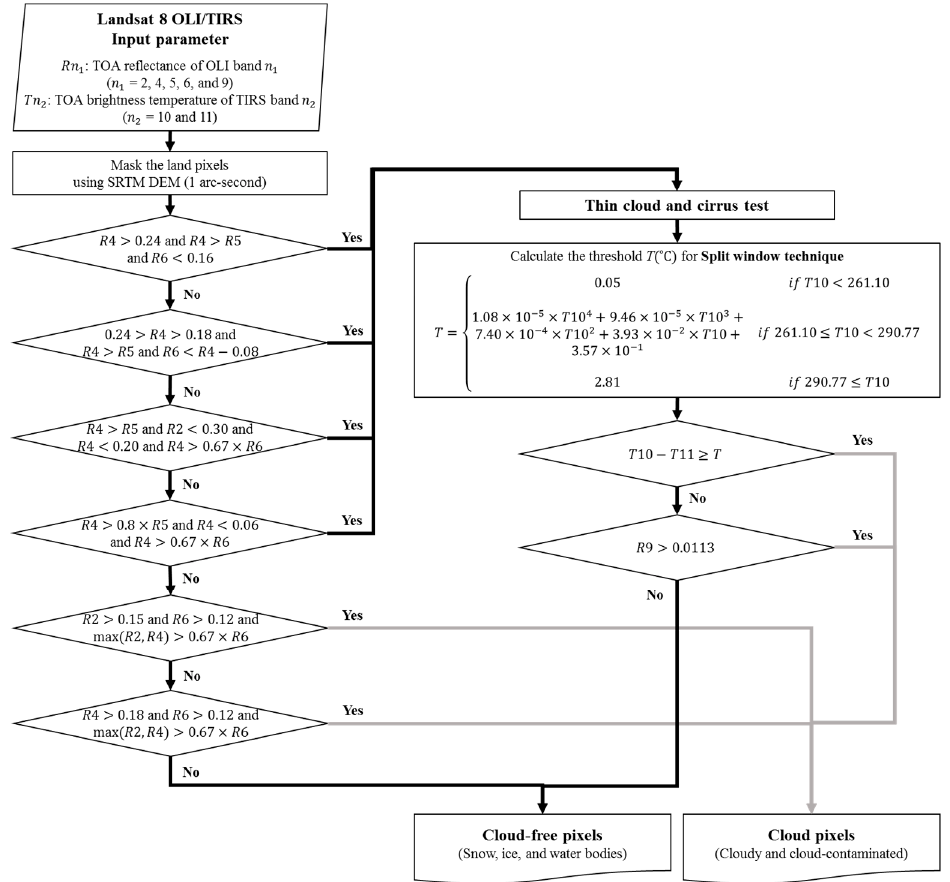
Figure 3. Flow chart of the pixel classification algorithm into the cloud-free pixels, including snow, ice, and water bodies, and cloud pixels, including cloudy and cloud-contaminated (max( a , b ): the maximum value of a and b ).